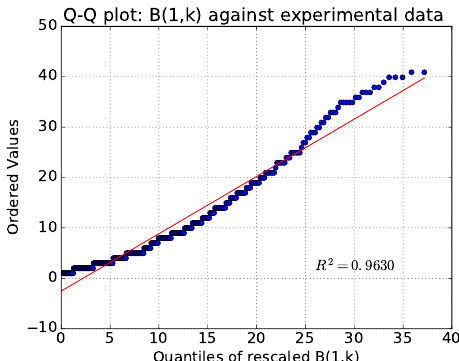
Figure 7. Comparing experimental distribution of delays with theoretic model distribution, through Q-Q